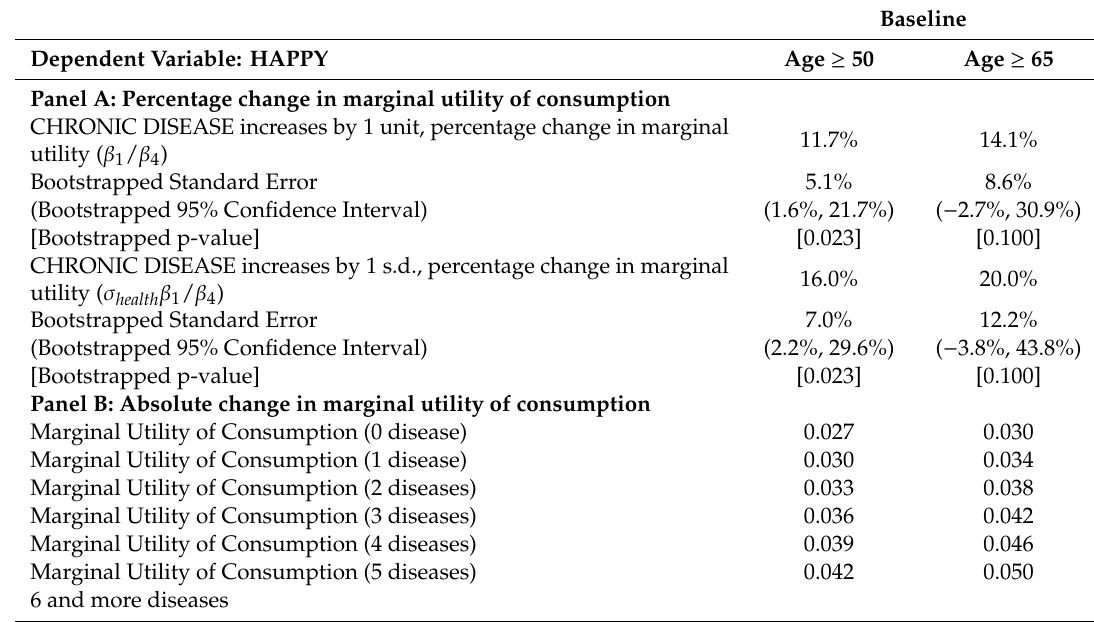
Table 3. E ff ect of health status on marginal utility of